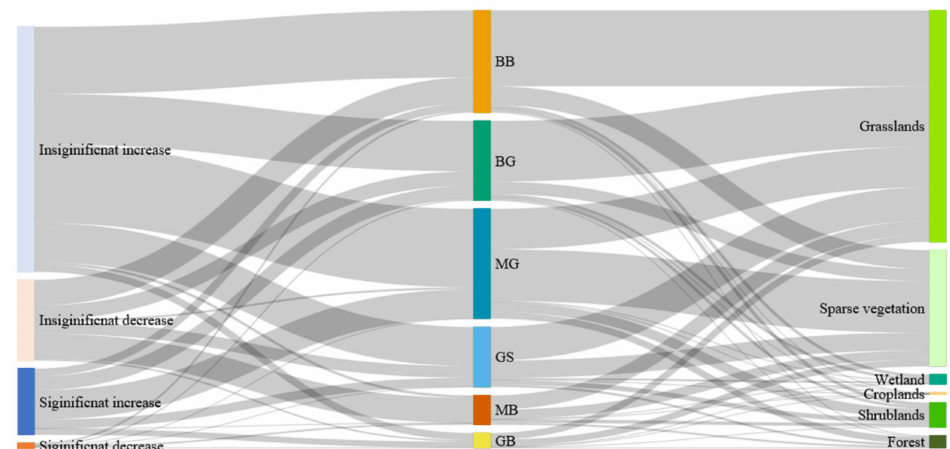
Figure 12. Sankey diagram of tendencies of linear regression, shift types generated by BFAST, and land cover types in the QNNP. Abbreviations: MG, monotonic greening; GS, greening with setback; BG, browning to greening; MB, monotonic browning; BB, browning with burst; GB, greening to browning. Non-vegetation areas were masked out by white